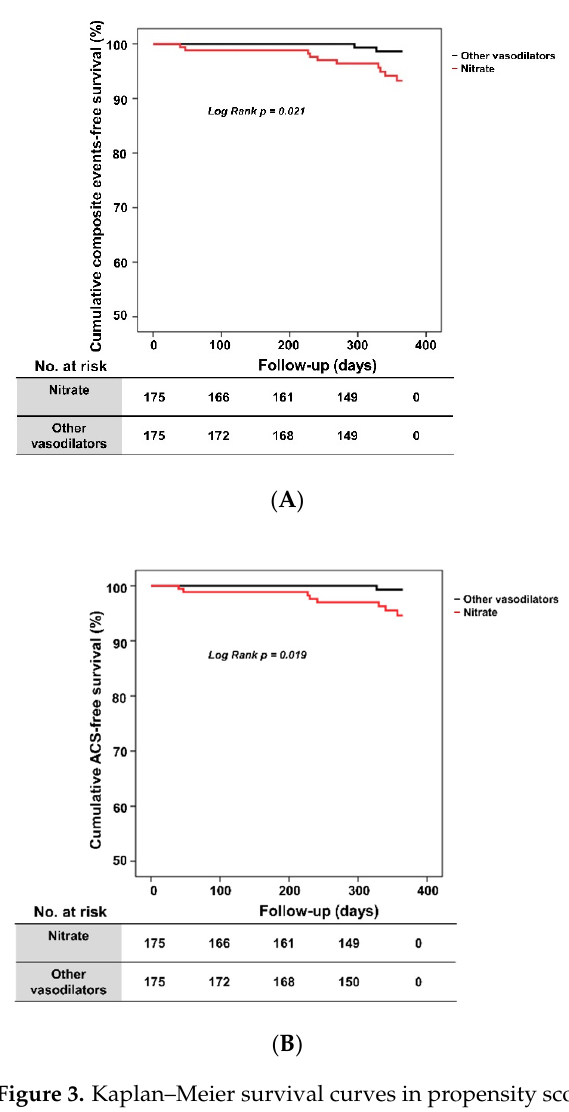
Figure 3 . Kaplan–Meier survival curves in propensity score ‐ matched population. ( A ) Cumulative Figure 3. Kaplan–Meier survival curves in propensity score-matched population. ( A ) Cumulative composite events ‐ free survival according to vasodilator. ( B ) Cumulative ACS ‐ free survival accord ‐ composite events-free survival according to vasodilator. ( B ) Cumulative ACS-free survival according ing to vasodilator. ACS, acute coronary syndrome. to vasodilator. ACS, acute coronary